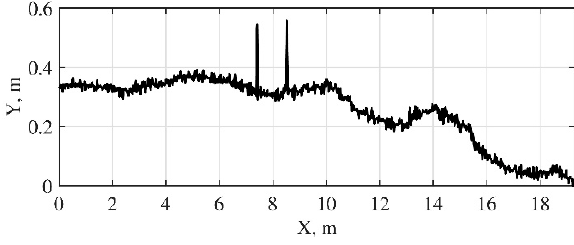
Figure 5. View of oscillations and interference on a selected fragment.